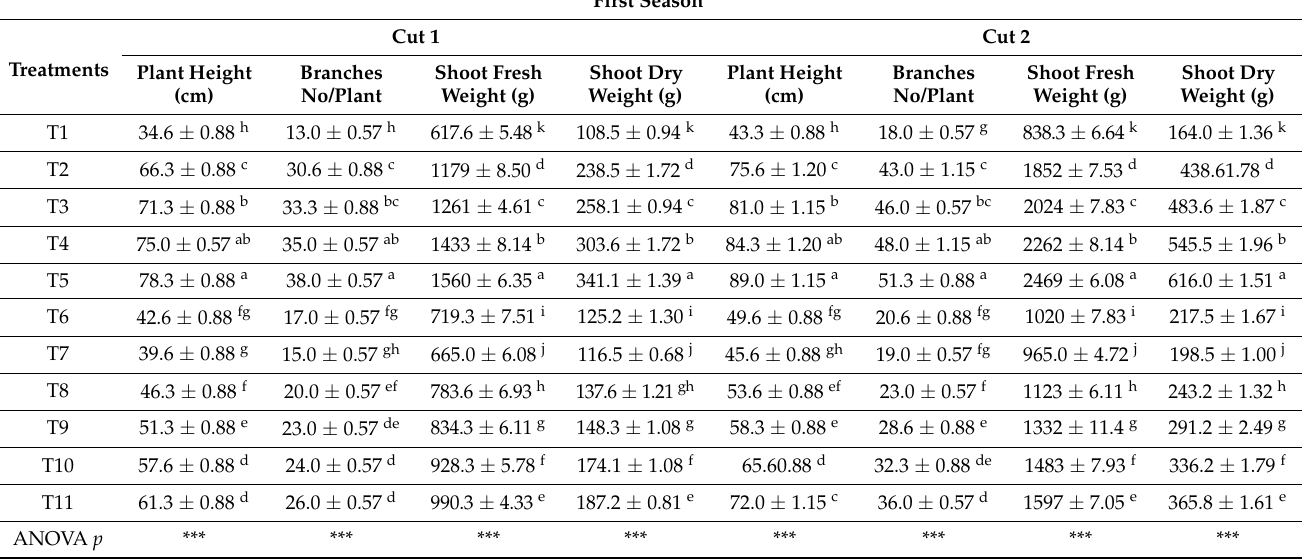
Table 3. Effect of iron (nano, sulfate, and chelated) foliar spray on some vegetative growth parameters of Sweet Scented geranium during the 2018 and 2019 experimental seasons. Means of three replicates are presented with ± SE.